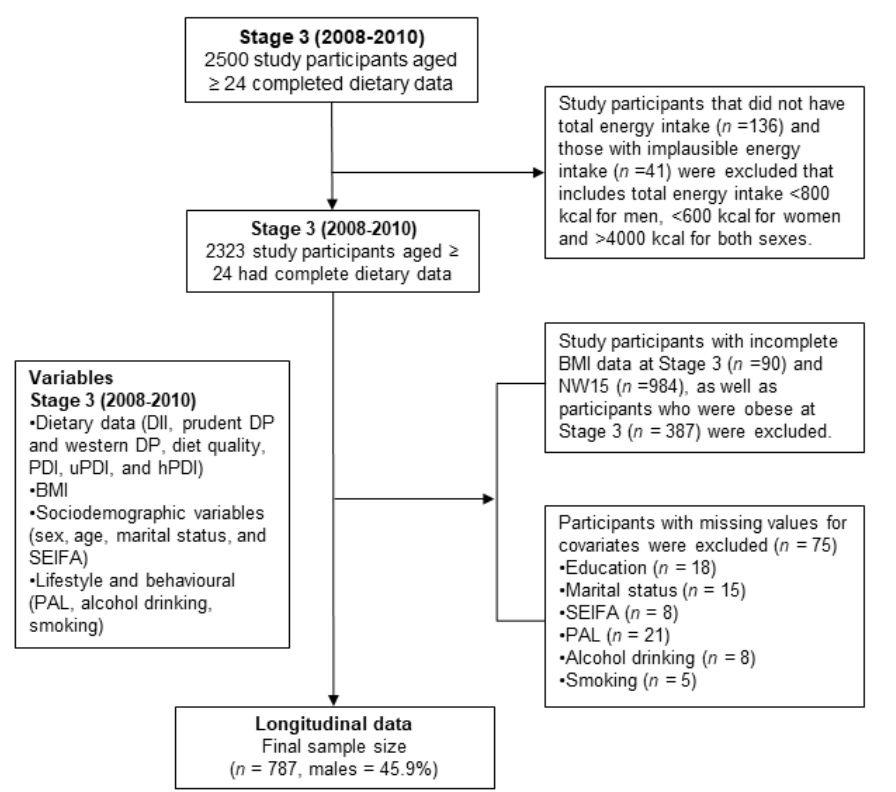
Figure 1. Sampling description of the study participants in the North West Adelaide Health Study (NWAHS). BMI: body mass index; SEIFA: Socio-Economic Indexes for Area; PAL: Physical Level Activity; DII: Dietary Inflammatory Index; DP: dietary pattern; PDI: Plant-based Dietary Index; uPDI: unhealthy Plant-Based Dietary Index; hPDI: healthy Plant-Based Dietary Index.